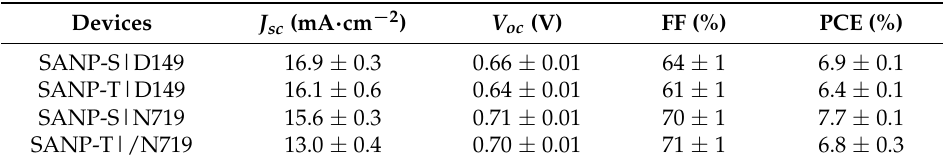
Figure 6. ( a ) Current–voltage (J–V) characteristics of SANP-S- and SANP– based devices using D149 or N719, measured under 1 sun illumination with an active area of 0.16 cm 2 ; ( b ) incident photon to charge carrier efficiency (IPCE) of the devices in ( a ). Table 2. J–V parameters of devices based on either SANP-S or SANP-T sensitised with D149 or N719, including short circuit current density ( J sc ), open circuit voltage ( V oc ), fill factor (FF) and photovoltaic conversion efficiency (PCE).